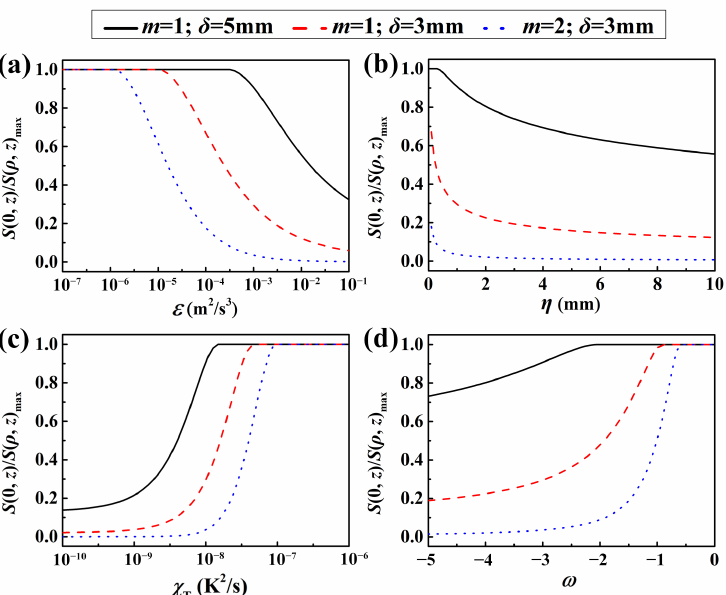
Figure 5. Ratio of the spectral intensity in the optical axis to the maximum intensity in the transverse plane of SSS beams for different beam orders and coherence lengths versus various oceanic turbulence parameters: ( a ) the kinetic energy dissipation rate per unit mass of the fluid; ( b ) the Kolmogorov inner scale; ( c ) the dissipation rate of the mean-square temperature; ( d ) the relative strength of the temperature to salinity undulations.